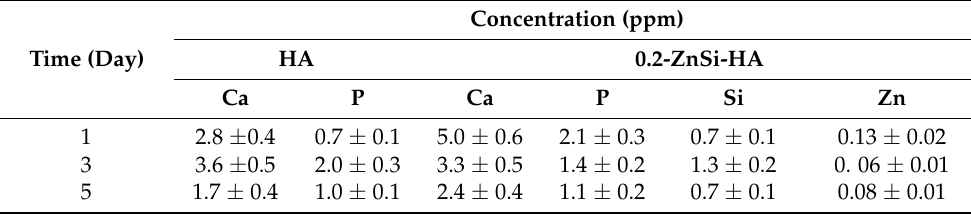
Table 4. Results of elemental analysis of solutions after soaking powders in water. Concentration (ppm) HA 0.2-ZnSi-HA Time (Day)